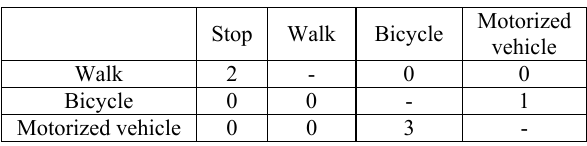
Table 2. Error matrix of first-stage